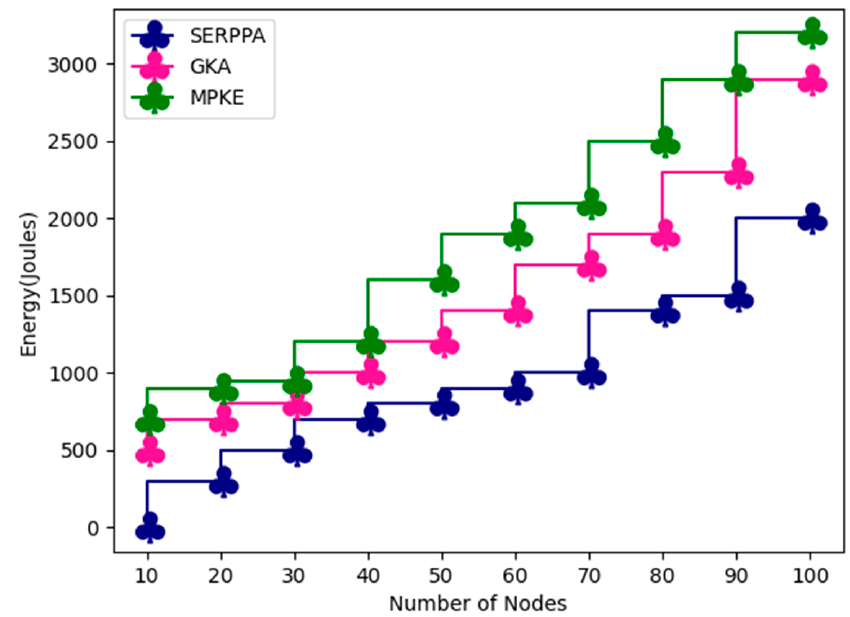
Figure 4. Energy vs. number of nodes.